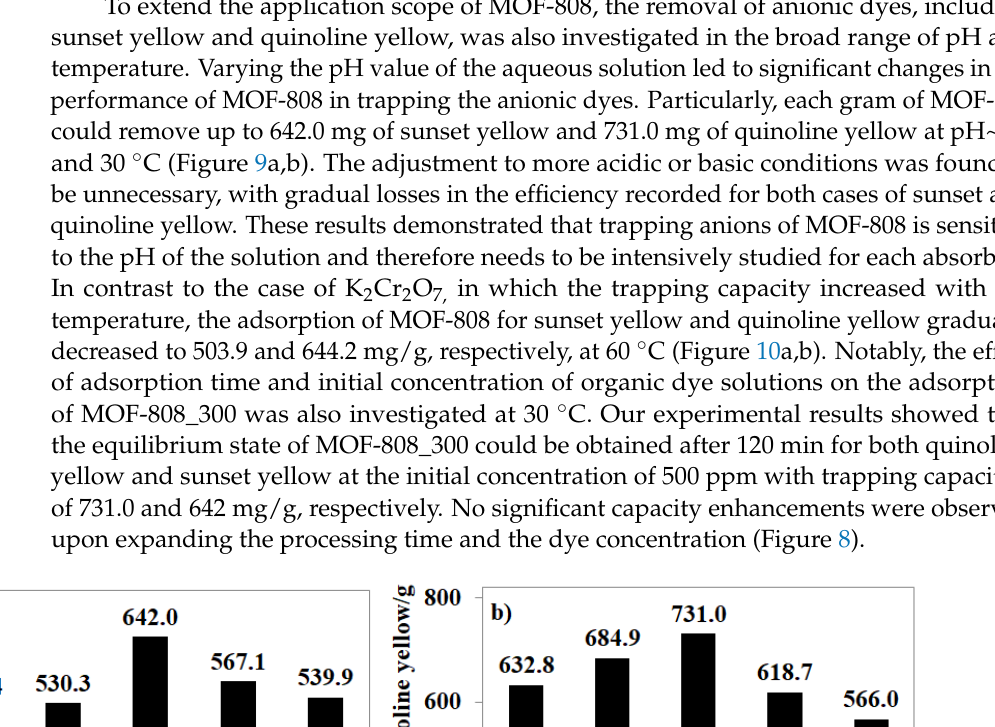
Figure 10. Effect of temperature on sunset yellow ( a ) and quinoline yellow ( b ) trapping capacity of MOF-808_300 at 30 °C. Some popular MOFs with open metal sites, including MOF-199 (open copper centers) and MIL-101 (open iron centers), have been recently employed to remove sunset and quin- oline yellows from water; however, these materials exhibited adsorption capacities of: 65.4 mg of quinoline yellow/g of MOF-199 and 81.3 mg of sunset yellow/g of MIL-101 at am- bient temperature (Entry 9–10_Table 3) [46–48]. These uptake values are 7-fold and 12- fold lower than those of sunset yellow and quinoline, respectively, by the MOF-808_300 in the present work. Poor performances of MOF-199 and MIL-101 perhaps derive from the oversensitivity of the open metal centers, which are easier to be blocked by water mol- ecules than to capture dye anions [49]. For comparison purposes, a commercial activated carbon was used as an adsorbent for the adsorption of quinoline yellow and sunset yellow under the same conditions as performed on MOF-808_300. The activated carbon showed an adsorption capacity of about 97 mg/g for both organic dyes (Entry 12_Table 3), which were still significantly lower than those of the MOF-808_300. Obviously, a MOF-808 with a 6-connected Zr-cluster offers a better platform with a superior adsorption capacity for anion trapping in an aqueous solution.